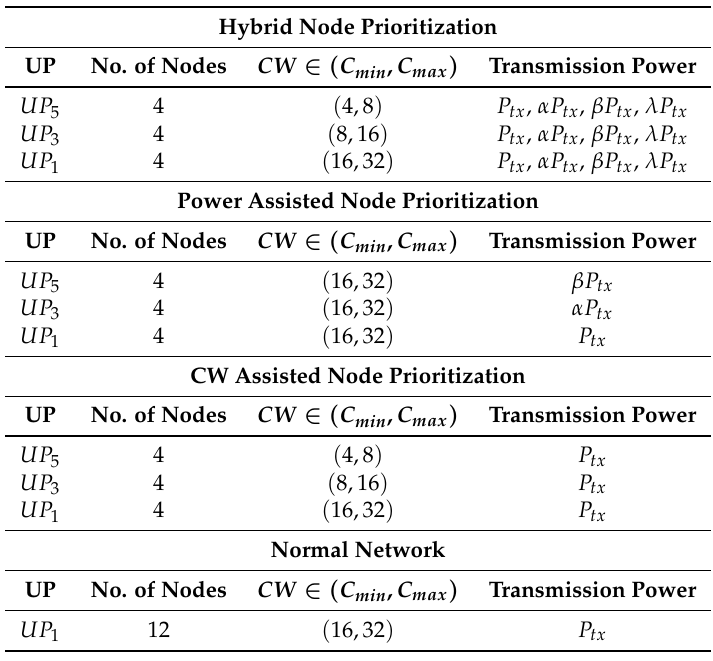
Figure 9. Packet collision avoidance scenario in power assisted CSMA/CA. Table 2. Simulation parameters for prioritized and normal